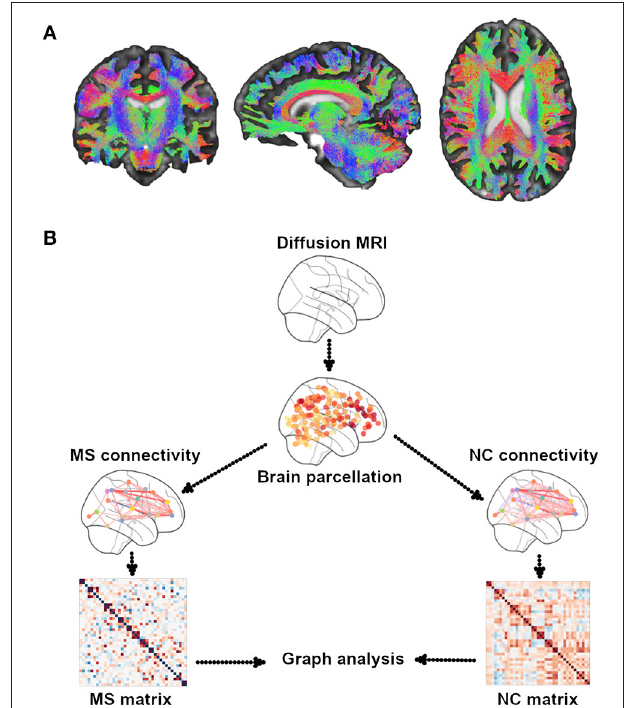
FIGURE 1 | Illustrative example of WM tractography. (A) Different colors show the three systems of WM tracts: red for commissural (laterolateral direction), green for association (anterior–posterior direction), and blue for projection (superior-to-inferior direction). WM tractography were overlaid onto